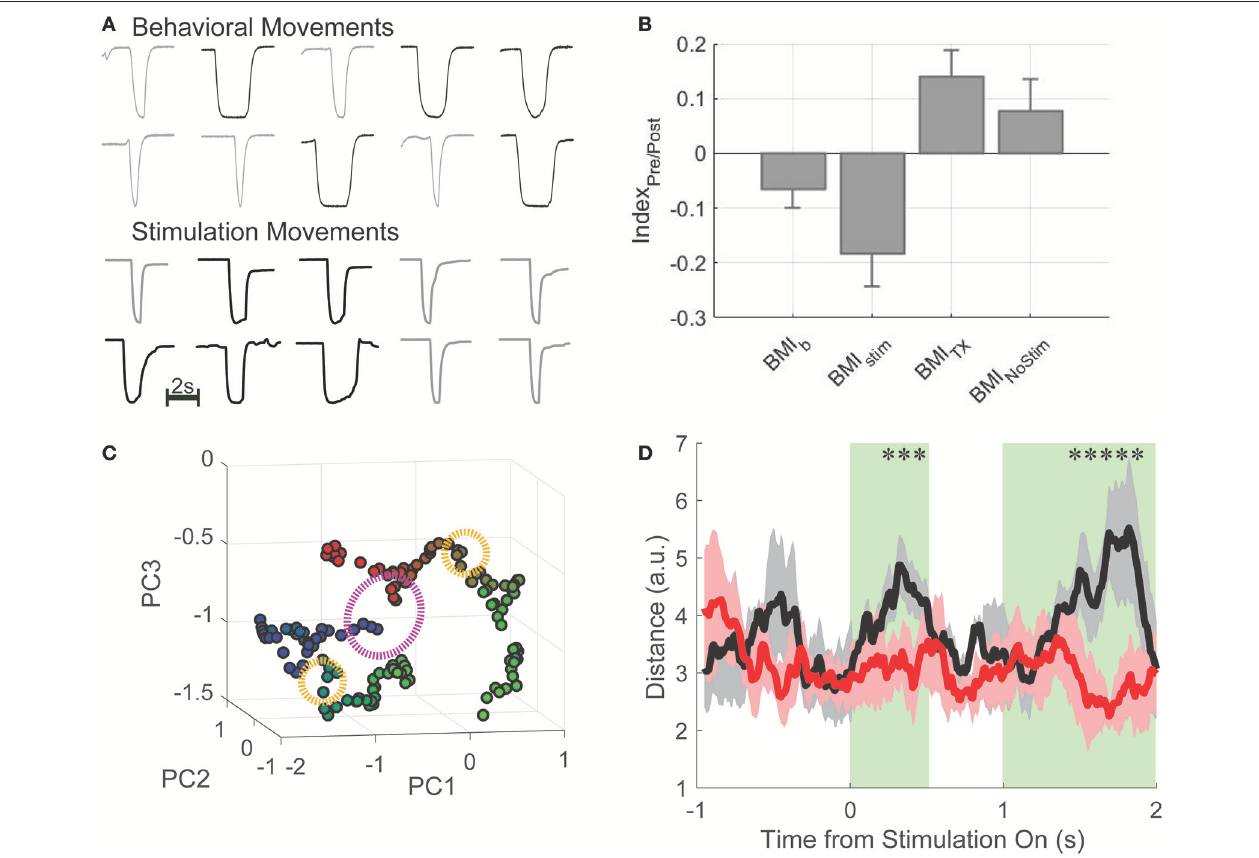
FIGURE 4 | BMI-FES. (A) Example hindlimb amplitude traces (in volts, peak displacement, which is similar across all trials is ∼ 2cm; bar indicates 2s) generated by normal behavioral movements (top) compared with artificial movements driven by the cortically-controlled epidural stimulator in the same animal after spinal injury. Qualitatively, endpoint trajectories are similar. (B) We computed an information index that describes the relationship between information encoded about press duration during the first 500ms of the decoding period and the first 500ms of the stimulation period. We found that stimulation trial indices (BMI stim ) most closely matched those from the BMI-b condition, while post-TX trials without stimulation (BMI NoStim ) had index values closer to BMI-tx values. (C) Using dimensionality reduction, we show that the state of the neural population (green clusters representing post-cue window) is different for long (blue) compared to short (red) trials, and has a marked effect on how stimulation (orange circles) affects population activity. Subsequent evolution of the neural trajectories after stimulation onset (when green turns to blue for long duration presses and green to red for short duration presses) showed that the trajectories follow different paths despite the fact the stimulation is the same (purple circle denotes 500ms post-stimulation onset). (D) Euclidean distance between trajectories generated during short and long duration trials during stimulation sessions (black curve) and during non-stimulation sessions (red curve). *Denotes deviation from 95% confidence interval and shaded in